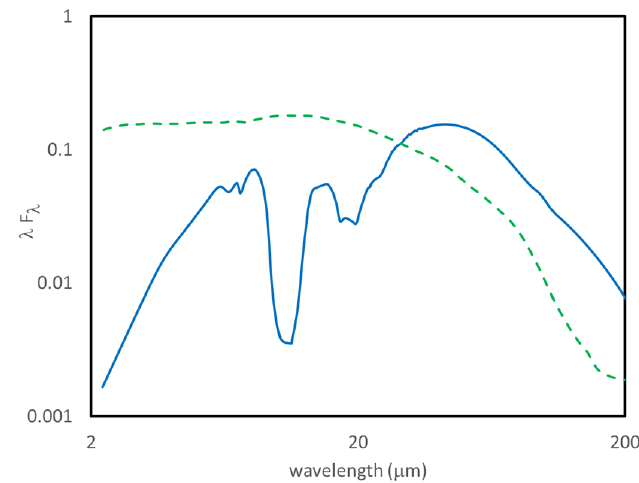
Figure 9. IR SED of IRAS08572+3915 (solid blue line) compared with “normal” template (dashed green line). The SED of IRAS08572 has been normalized to half the IR luminosity of the normal template, on the assumption that half the luminosity of the template escapes at shorter wavelengths, whereas all of the shorter-wavelength energy is captured and reradiated in IRAS08572, doubling its IR output relative to that of the template. This normalization puts the normal SED at its highest plausible level relative to IRAS08572, but nonetheless there is excess far-IR emission above